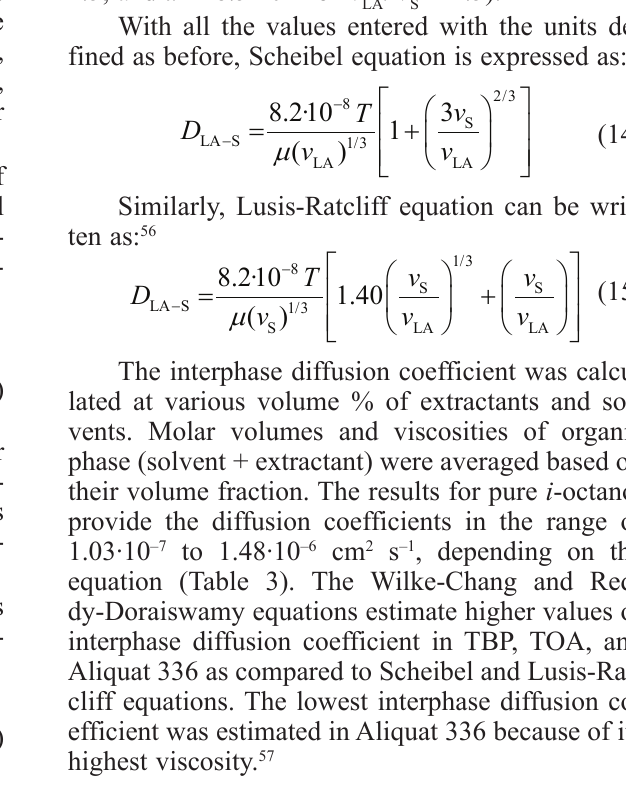
Table 3 – Diffusion coefficient (D ) of levulinic acid in reactive solvent phase from the Wilke-Chang, Reddy-Doraiswamy, Schei- LA-S bel, and Ratcliff equations at 298.15 ± 1 K Organic Solvents